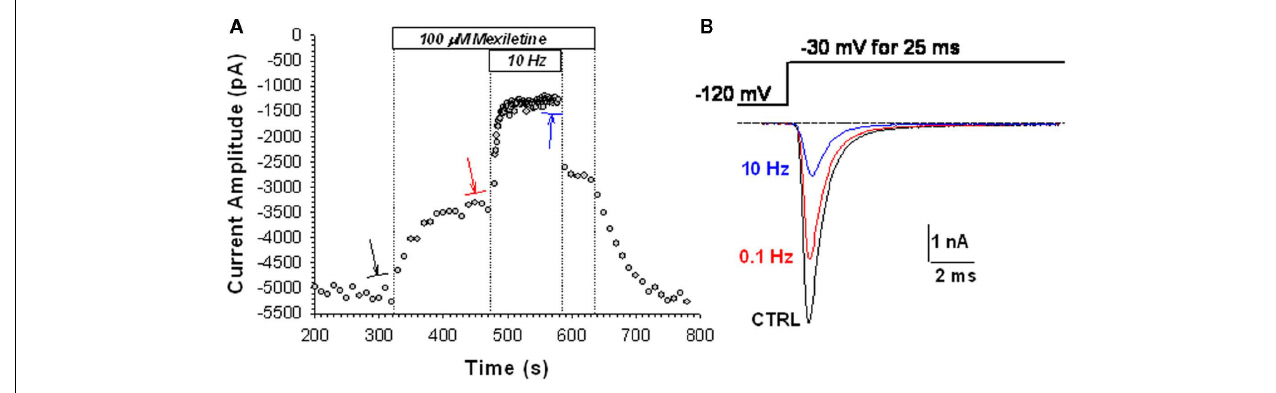
(0.1Hz) or 0.1s (10Hz), from a holding potential of − 120mV. (B) Typical sodium current traces are shown, which were obtained from the average of three records obtained at steady state in absence of drug using 0.1Hz stimulation frequency (CTRL), and in presence of drug at 0.1Hz (red) and 10Hz (blue).